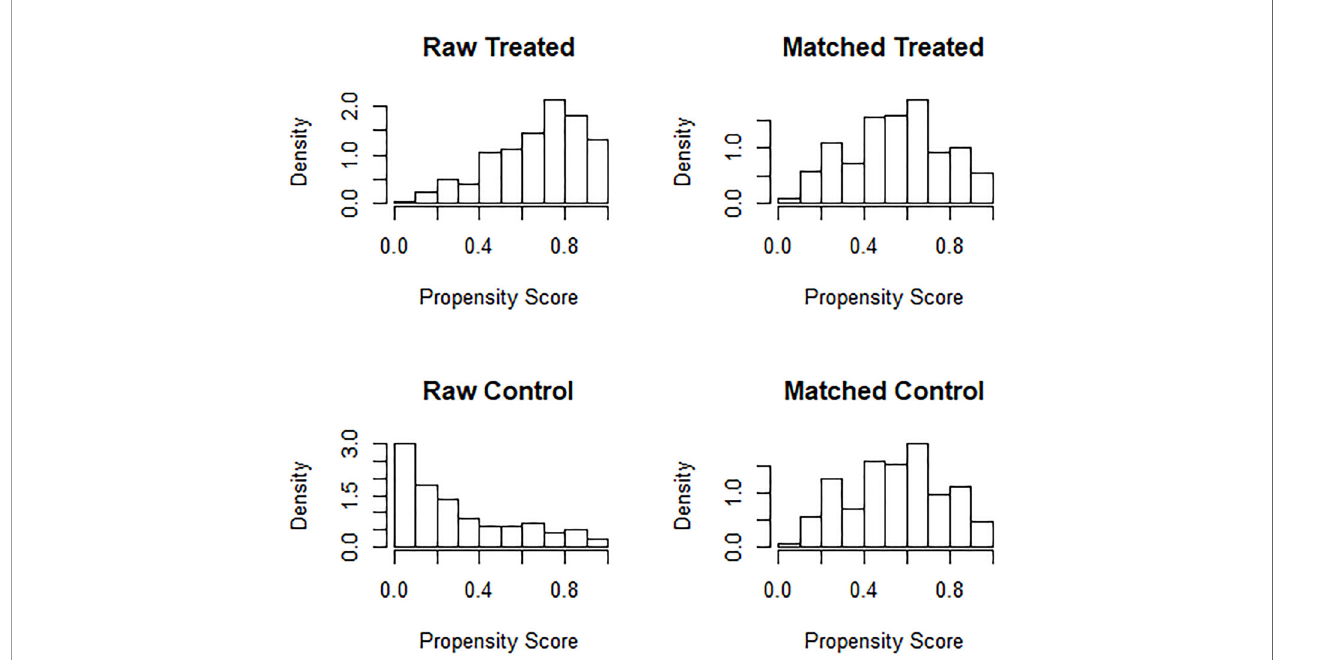
FIGURE 3 | Histogram of propensity scores of two groups before and after